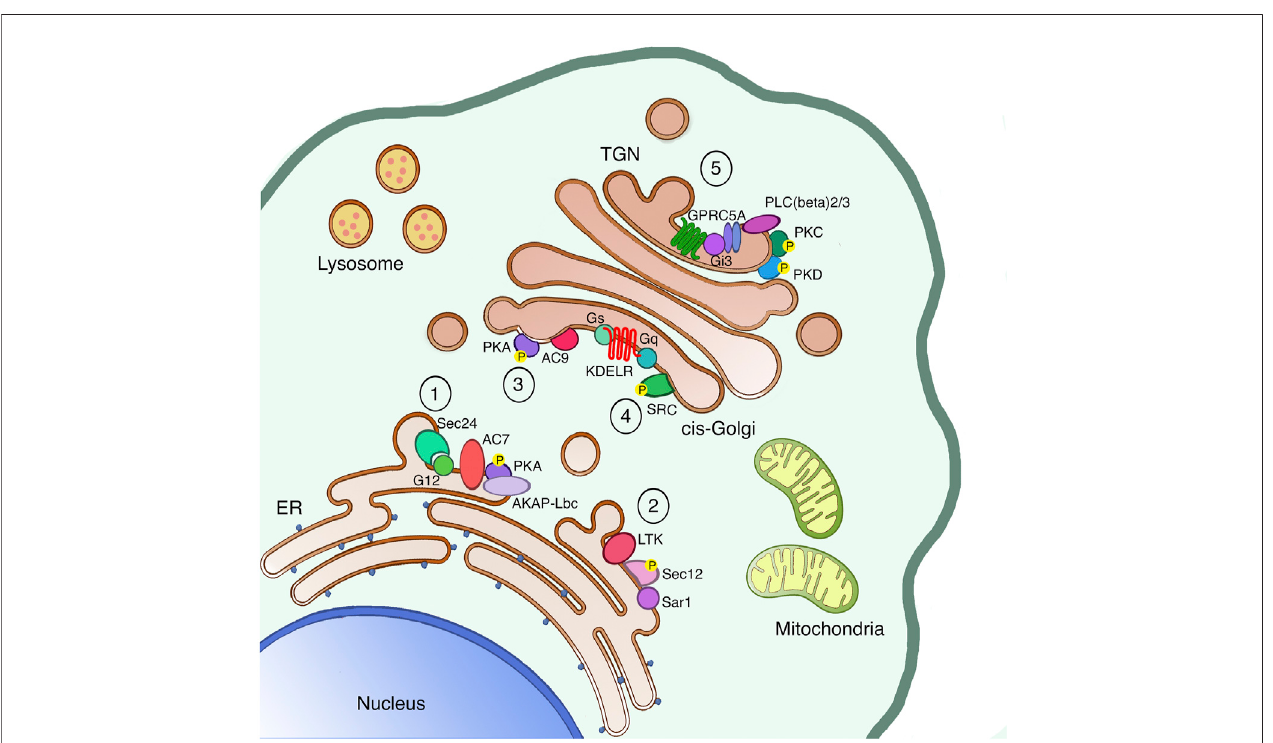
FIGURE 1 | The secretory pathway is a signaling platform. The secretory pathway hosts several signaling machineries, whose function as autoregulatory systems has been characterized in detail. The ER localized AREX complex (1) and LTK-dependent system (2) are involved in regulating ER export of different proteins. Once proteins leave the ER, also ER resident chaperones reach the cis-Golgi, where they bind and activate the KDELR. Indeed, the KDELR activation stimulates both the Gs-PKA signaling (3) to regulate retrograde traf fi c and the Gq-SRC pathway (4) to promote the anterograde transport through the Golgi. Finally, proteins reach the TGN to be sorted and reach the fi nal destination either inside or outside the cell. Speci fi cally, basolateral proteins stimulate the GPRC5A receptor to activate PKD in order to exit the TGN (5).